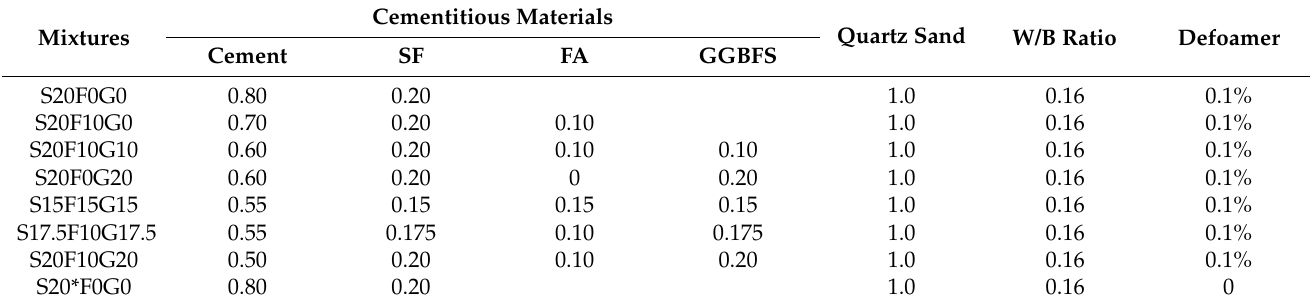
Table 2. Mix proportions of